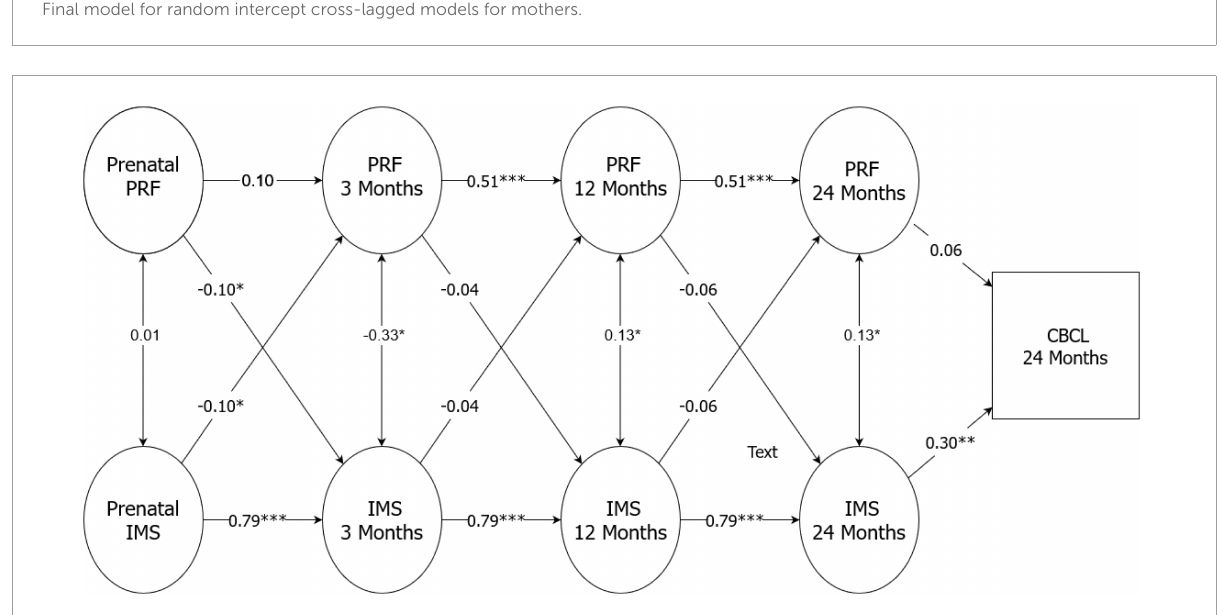
FIGURE2 Final model for random intercept cross-lagged models for